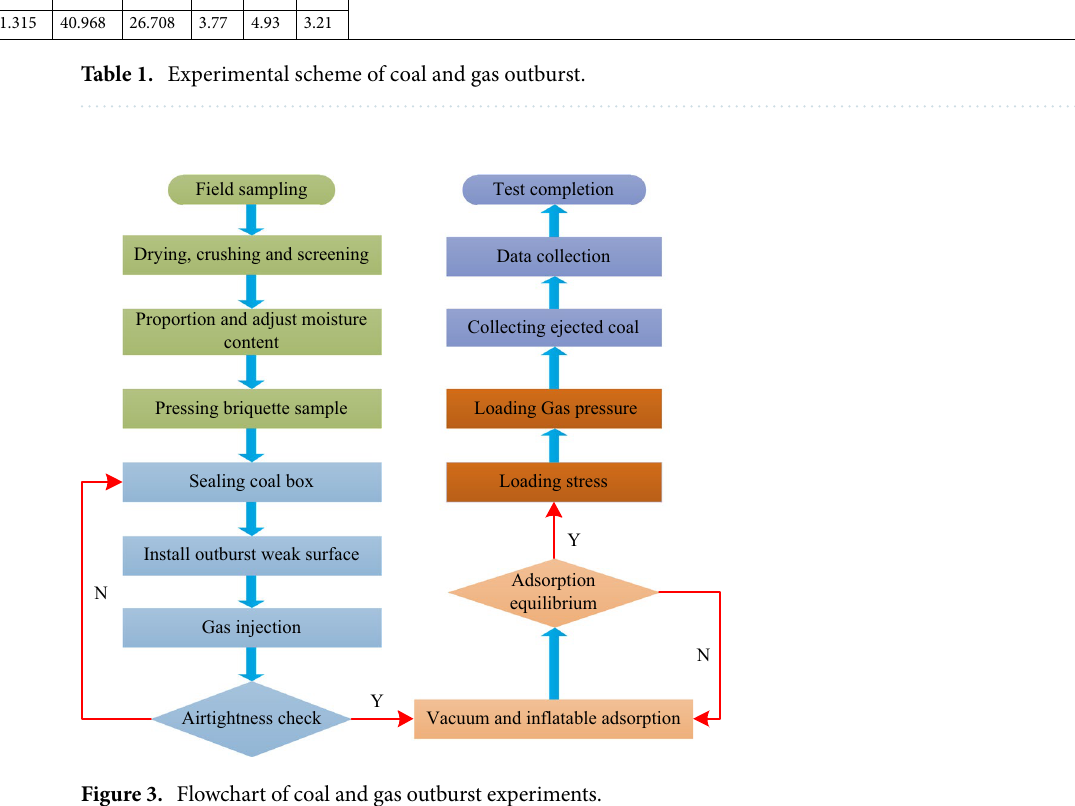
Figure 3. Flowchart of coal and gas outburst